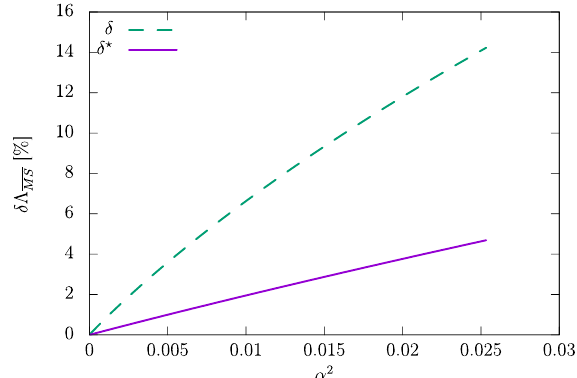
Fig. 12 Scale uncertainties for (cid:3) associated to different renormaliza- ( s μ) .Thesolidcurve(labeled δ (cid:14) )shows tionscalesforthecoupling ¯ g 2 MS the perturbative uncertainty estimated by varying the scale around the scale of fastest apparent convergence. The dashed curve (labeled δ ) showstheperturbativeuncertaintyestimatedbyvaryingthescalearound the physical scale. See text for more